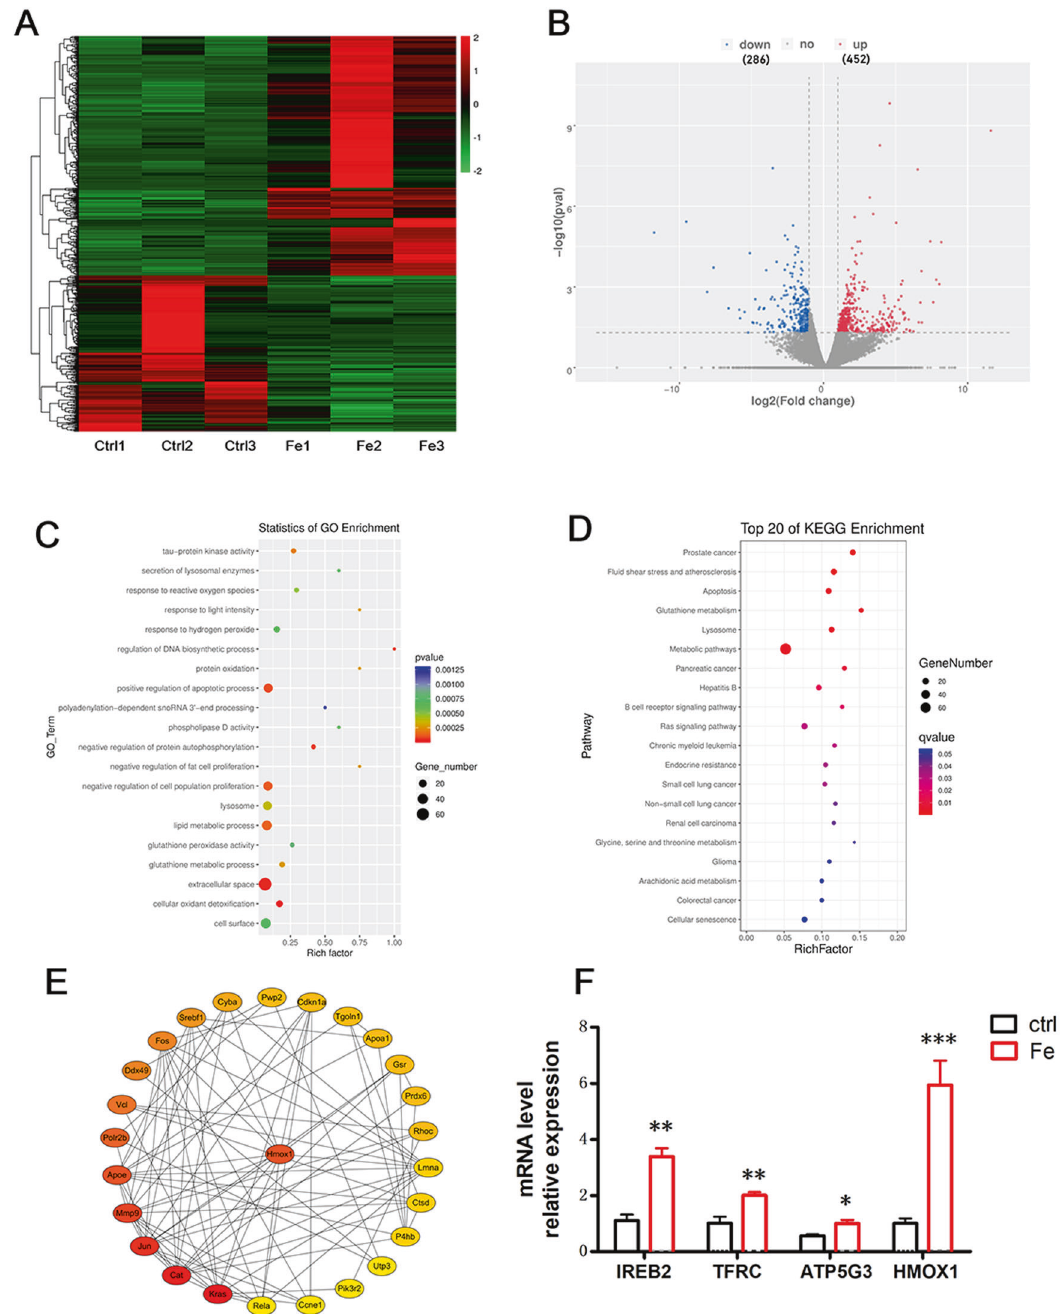
Fig. 5 Differential gene expression between control and Fe-treated mouse embryos. A Heat map of differentiated expression genes in mouse embryos between control and Fe-treated. Low expression is depicted in green, and high expression is depicted in red. B Volcano plot of gene expression (Fe vs. Ctrl; fold change ≥ 2; q value < 0.05), DEGs are represented by red dots (up regulated) and blue dots (down regulated), Non-DEGs are represented by gray dots. The abscissas represent the fold change in genes between the two experimental groups, and the ordinates represent the signi fi cance in the fold change in the gene expression. C GO analysis of differentially expressed genes in mouse embryos between the control and Fe-treated. D KEGG pathway analysis of RNA-seq data between control and Fe-treated mouse embryos. E The network of hub genes. The node represent genes, the shade of color indicates weighted degree score, and the black lines represent interaction. F The mRNA levels of HMOX1 and ferroptosis marker genes (IREB2, TFRC, and ATP5G3) were measured in Fe-treated mouse embryos and control group. * P < 0.05, ** P < 0.01, *** P < 0.001.